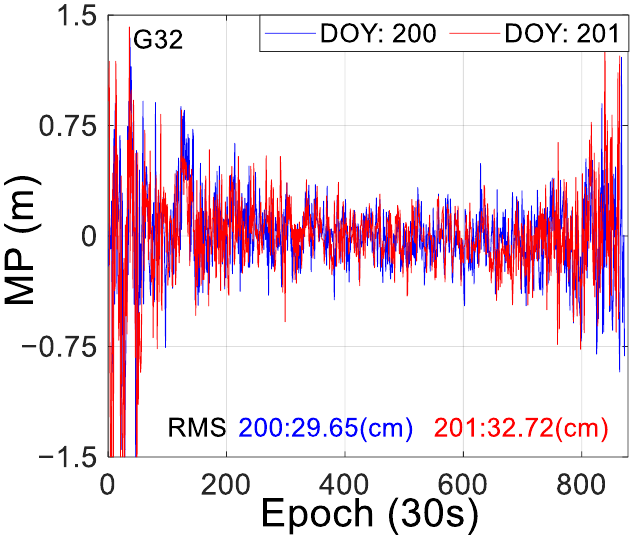
Figure 8. MP of GPS G32 satellite L1 frequency. The blue and red lines denote the MP on DOY:200 (no flood) and DOY:201 (with flood), 2021, respectively.